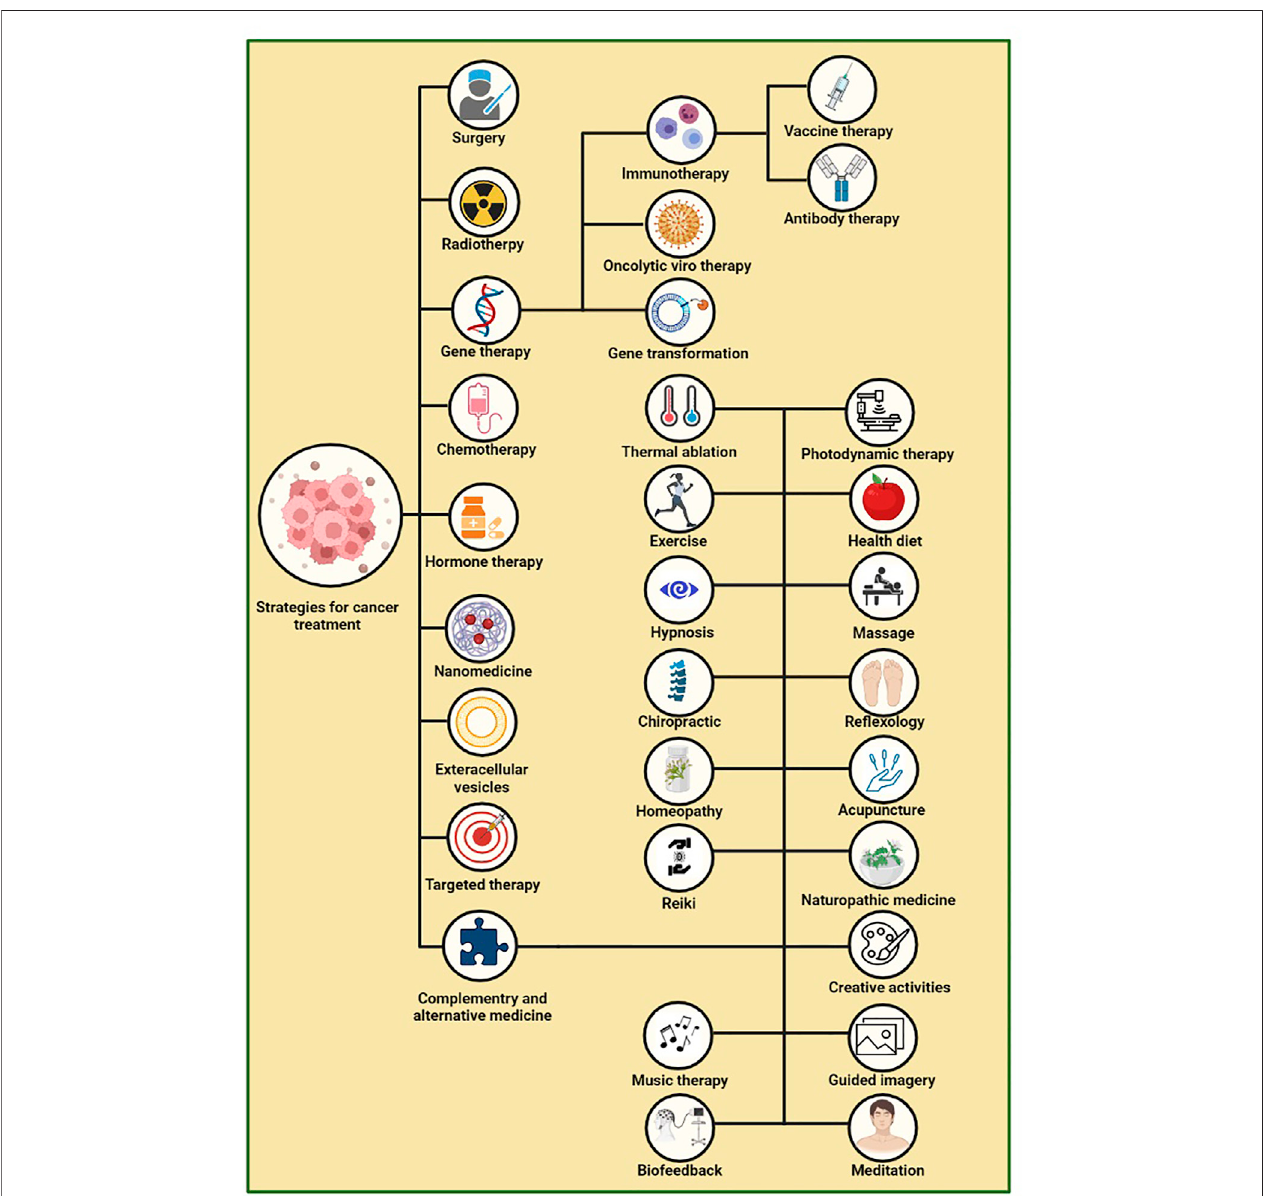
FIGURE1| Cancertreatmentapproaches(Tacón,2003;Roffeetal.,2005;JonesandDemark-Wahnefried,2006;Sagaretal.,2007;Luetal.,2008;Giustinietal., 2010; Masa fi et al., 2011; Stanczyk, 2011; Fleisher et al., 2014; Drãgãnescu and Carmocan, 2017; Bilgin et al., 2018; Carlson et al., 2018; Hojman et al., 2018; Yadav et al., 2018; Bidram et al., 2019; Psihogios et al., 2019; Pucci et al., 2019; Laoudikou and McCarthy, 2020; Najafpour and Shayanfard,